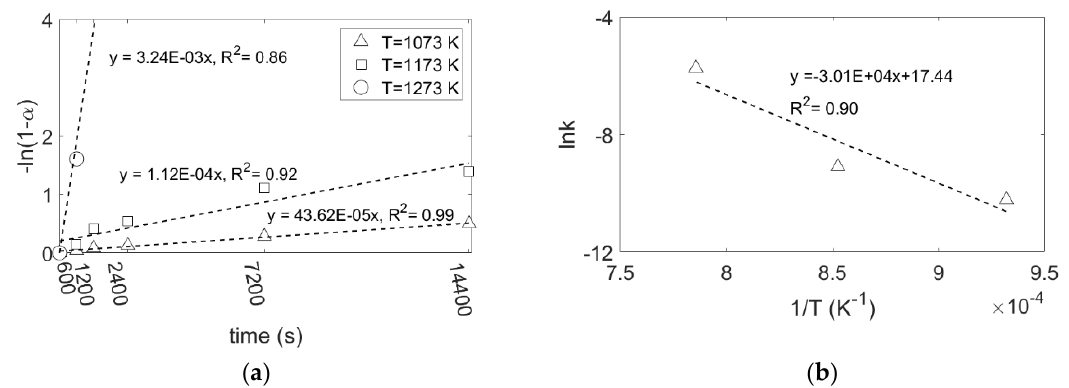
Figure 9. ( a ) Right-hand side of Equation (7) against reaction time at different reaction temperatures, first-order reaction model; ( b ) lnk against 1/T by using Equation (9).